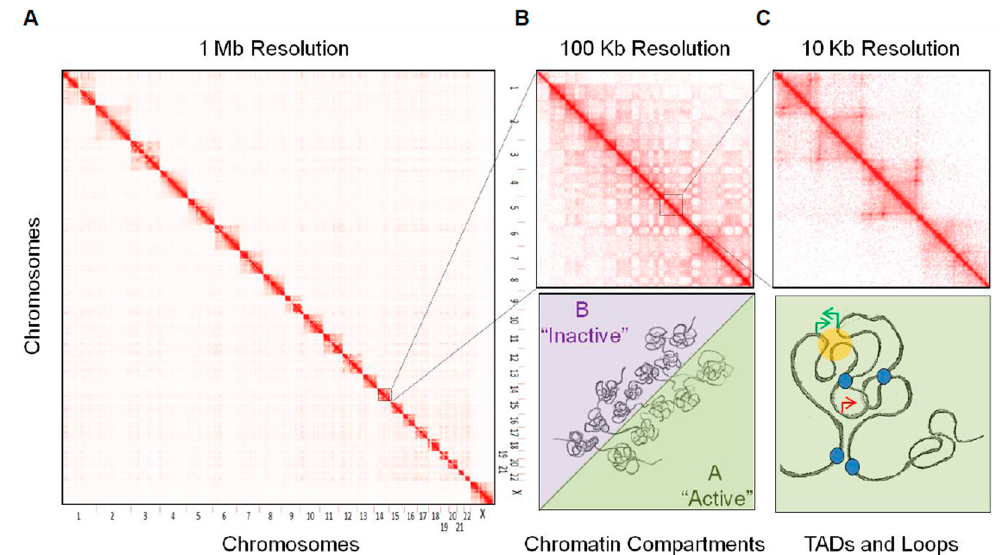
Figure 1. Hierarchical organization of the genome. Hi-C permits genome-wide detection of pair-wise contacts between genomic loci. They could be summarized as contact matrices where the color scale highlights the frequency of ligations events observed between any pairs of loci in the genome (from white to red, low to high frequencies, respectively). At different scales of resolution (e.g., 1 Mb, 100 or 10 Kb), higher orders of structure emerge: ( A ) chromosome territories, ( B ) chromatin compartments, ( C ) Topologically Associating Domains (TADs) and loops. ( B , C ) Bottom panels correspond to possible interpretations of the contact matrices: ( B ) active and inactive chromatin segregate spatially in two distinct chromatin compartments (A and B, respectively). ( C ) Architectural proteins (blue circles), such as CTCF (CCCTC-binding Factor), participate in the partitioning of the genome in TADs and generate sub-megabase structures, which can bring together specific loci or exclude genes from the activity of distal regulatory regions (orange circle: active enhancer; green arrows: expressed genes; red arrows: silenced genes).